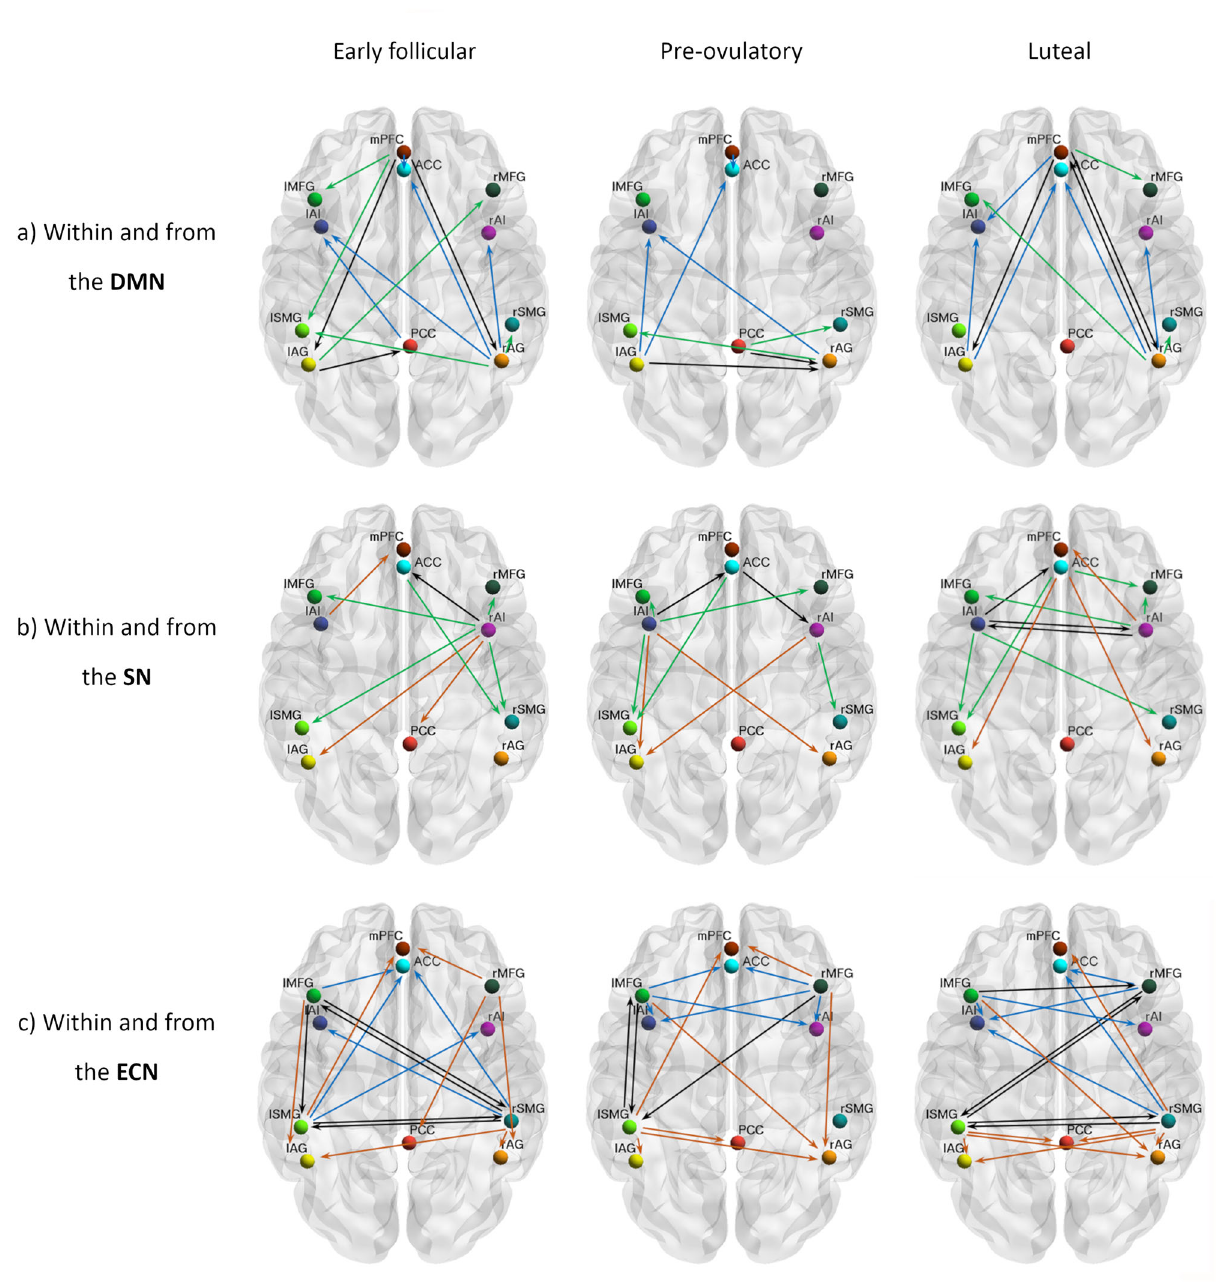
Fig. 5 Summary of cycle-related differences in within and between-network effective connectivity. Each row depicts the connections observed to be enhanced in each cycle phase compared to the others within and from ( a ) DMN; ( b ) SN; and ( c ) ECN. Only connections with a posterior probability >0.75 are displayed. Within-network connections are depicted in black and the efferent connectivity to the DMN in brown, to the SN in blue, and to the ECN in